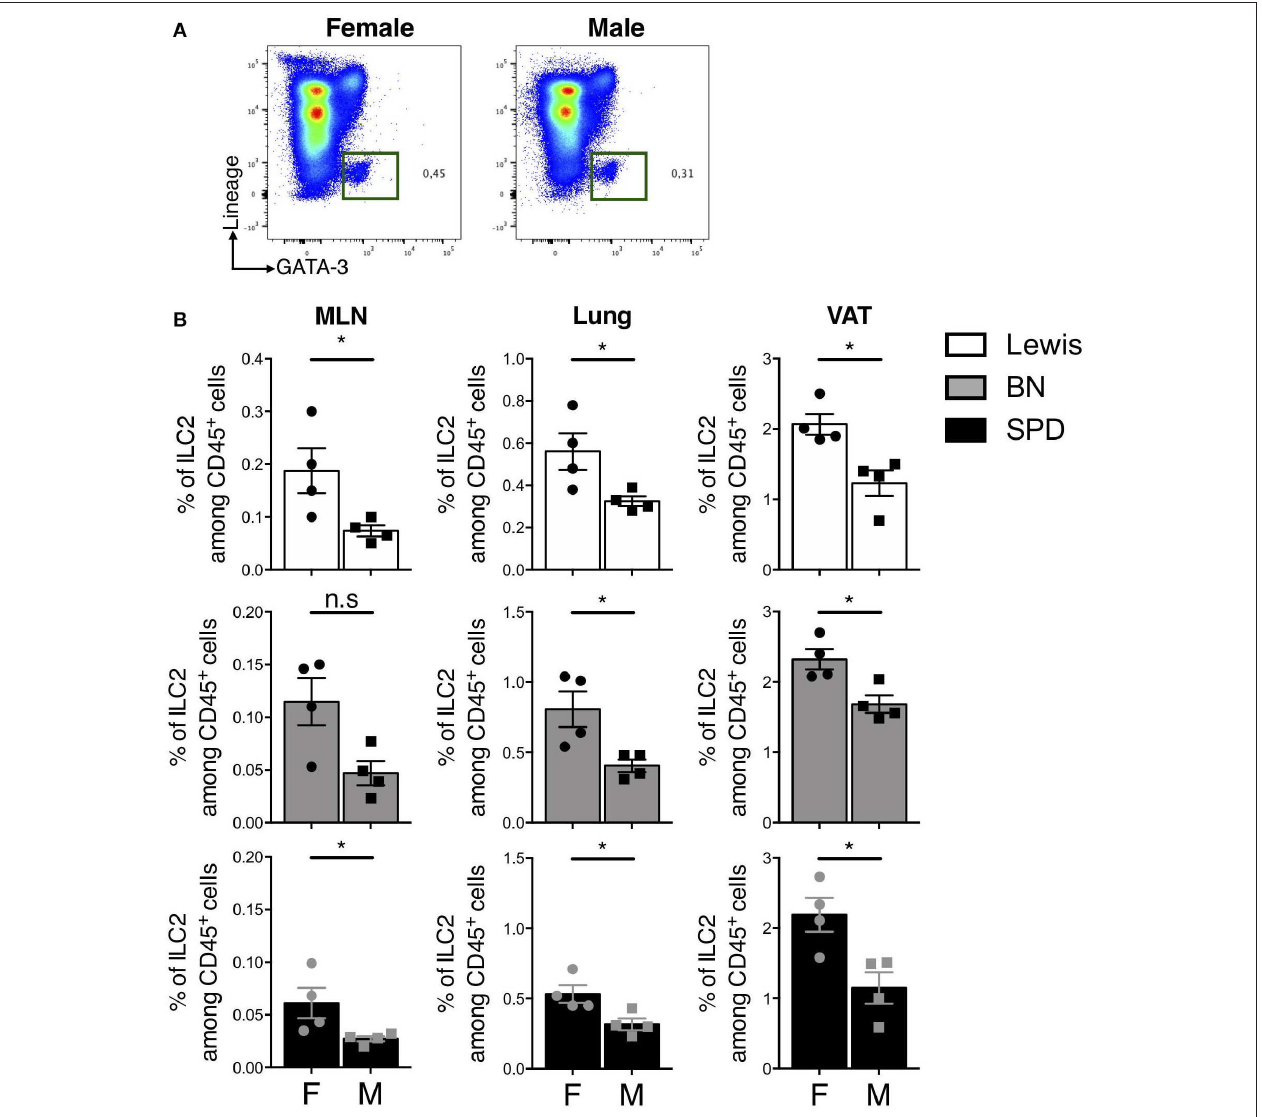
FIGURE 7 | Sex-effect on ILC2 proportions in MLN, lung and VAT of rats. (A) Representative plots of Lin − GATA-3 + (Pregated on live CD45 + cells) ILC2 in the lung of SPD female vs. male rats. (B) ILC2 frequencies in MLN, lung and visceral adipose tissues (VAT) of different rat strains. ( n = 4), numeric data represents means ± SEM, statistical differences were determined by nonparametric Mann Whitney test with significance was determined. F, Female; M, Male. * p < 0.05, n.s, not